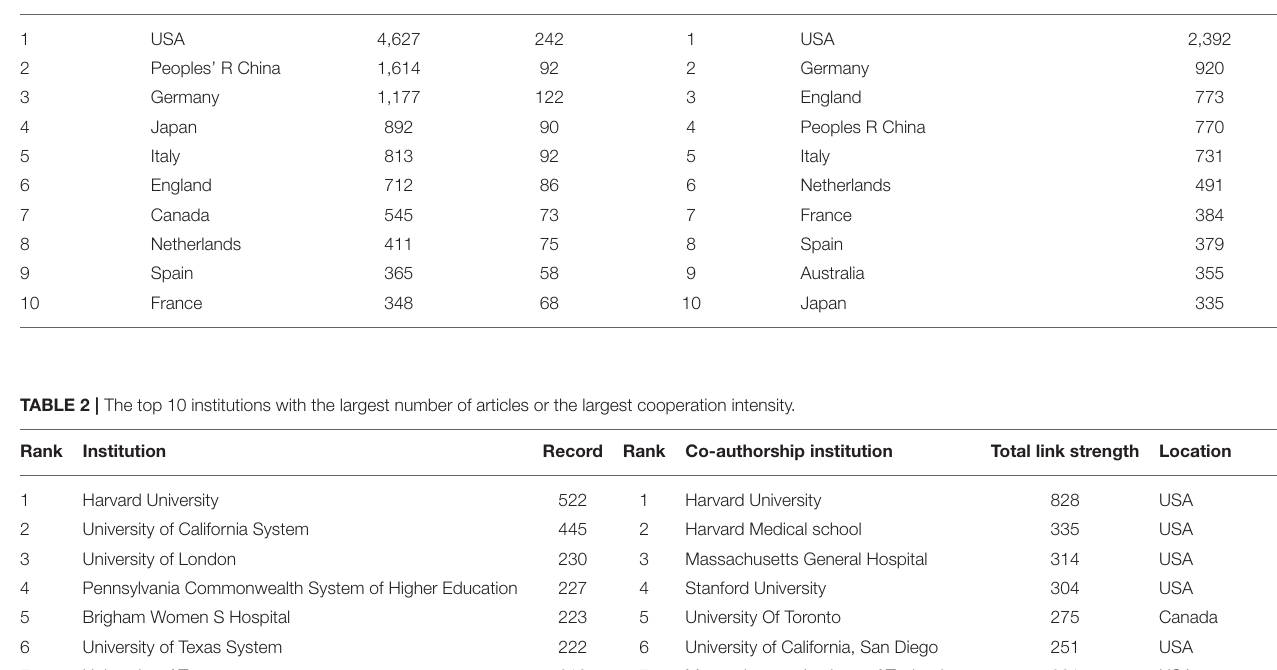
TABLE 1 | The top 10 countries/regions with the largest number of articles or the largest cooperation intensity. Rank Country/region